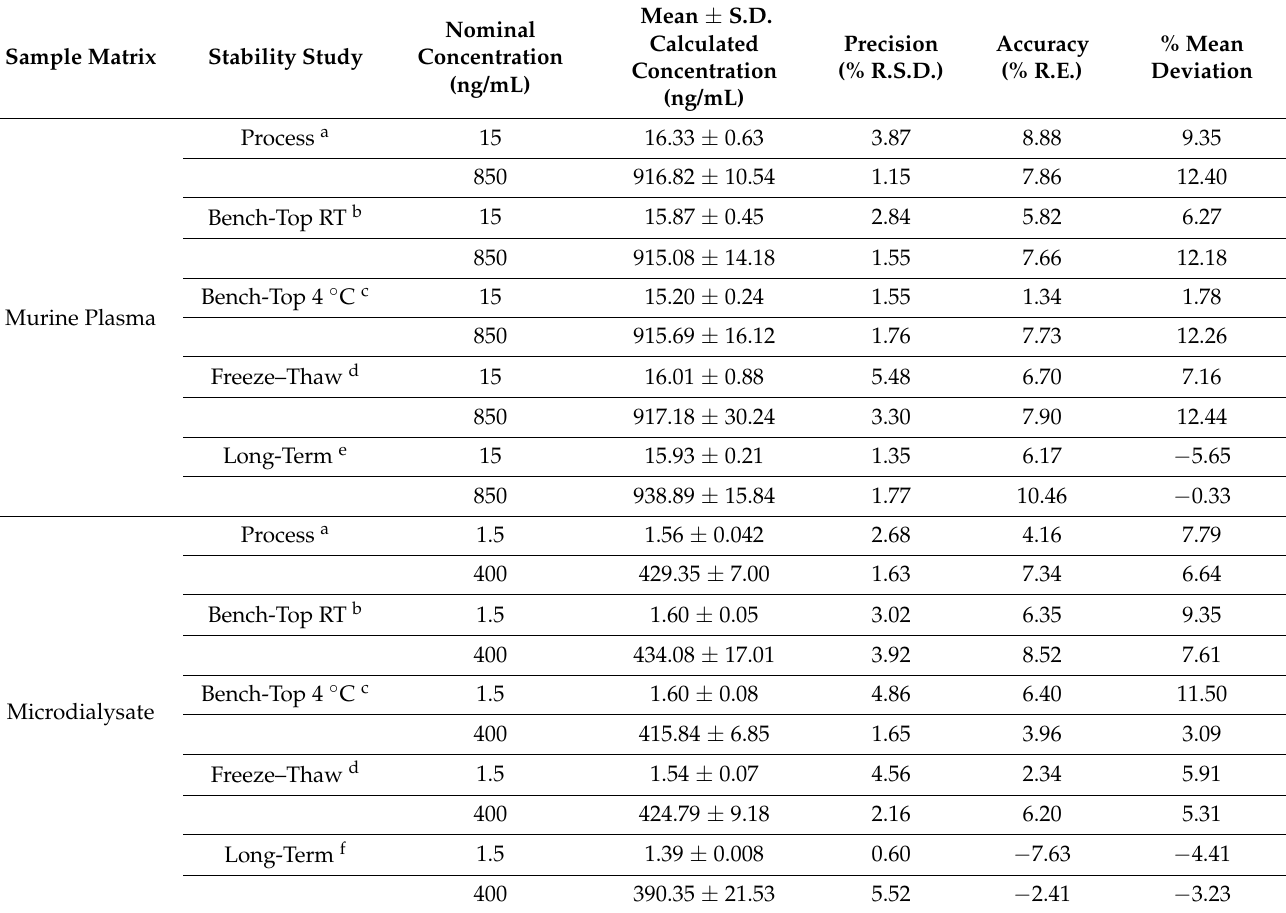
Table 5. Summary of stability evaluation for IWR-1-endo in murine plasma and microdialysates (n =